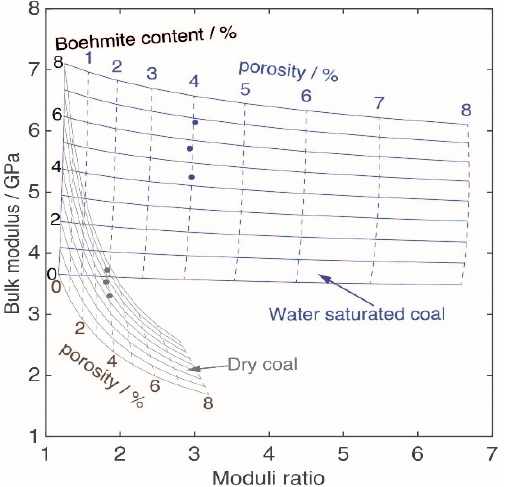
Figure 9. Schematic flowchart for building interpretation template for gallium-rich cores.